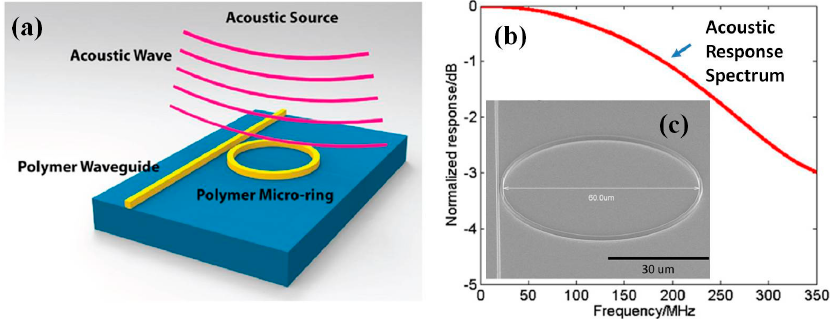
Figure 21. Ultrabroad bandwidth and highly sensitive optical ultrasonic detector for photoacoustic imaging: ( a ) schematic drawing of the ring working as an acoustic resonator; ( b ) simulated (red curve) detector frequency response curves; and ( c ) polymer ring fabrication by nanoimprinting lithography. (c) Angle view SEM of the microring with a diameter of 60 µm (R eproduced with permission from ACS [116]).